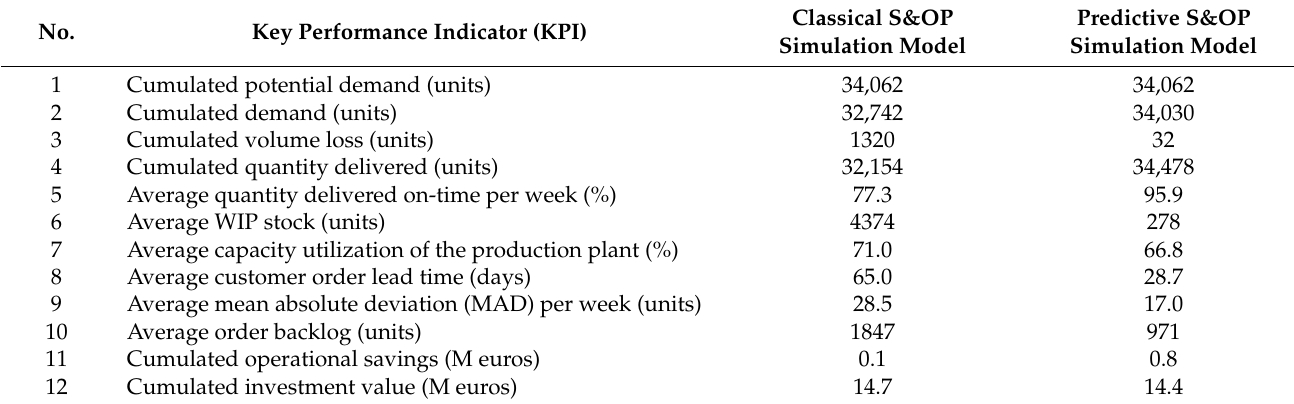
Table 8. Simulation results for demand scenario 1 (probable scenario).